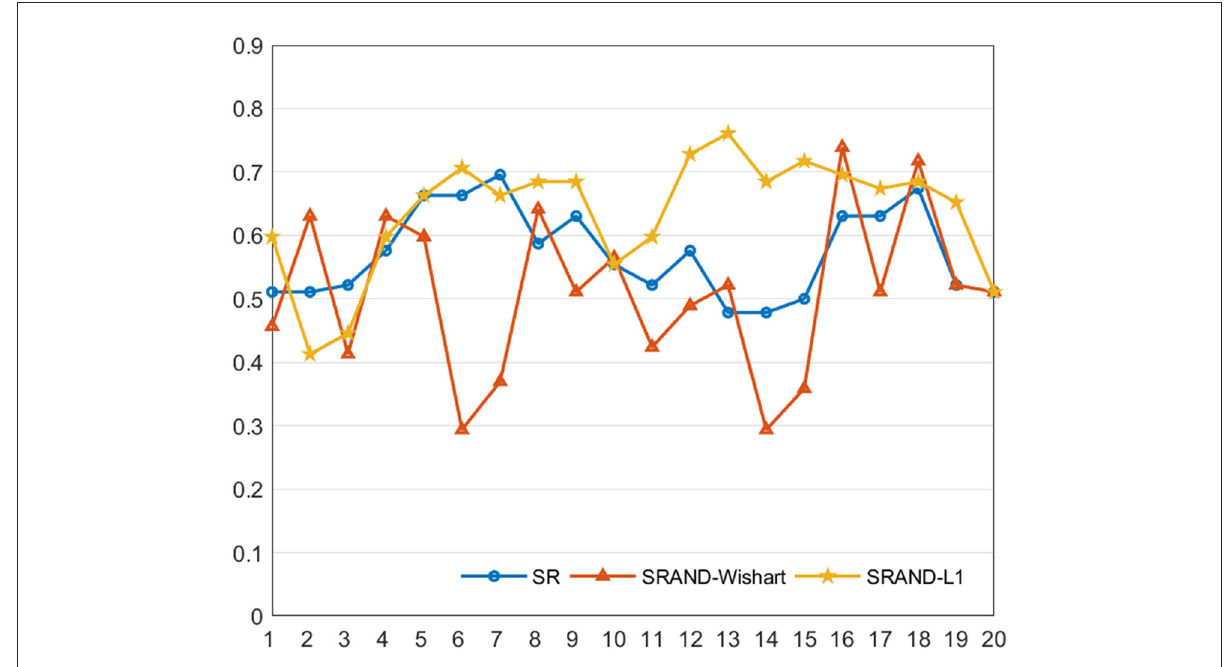
FIGURE3 Classification accuracy of the FBN estimated by three comparison methods on 20 regularized